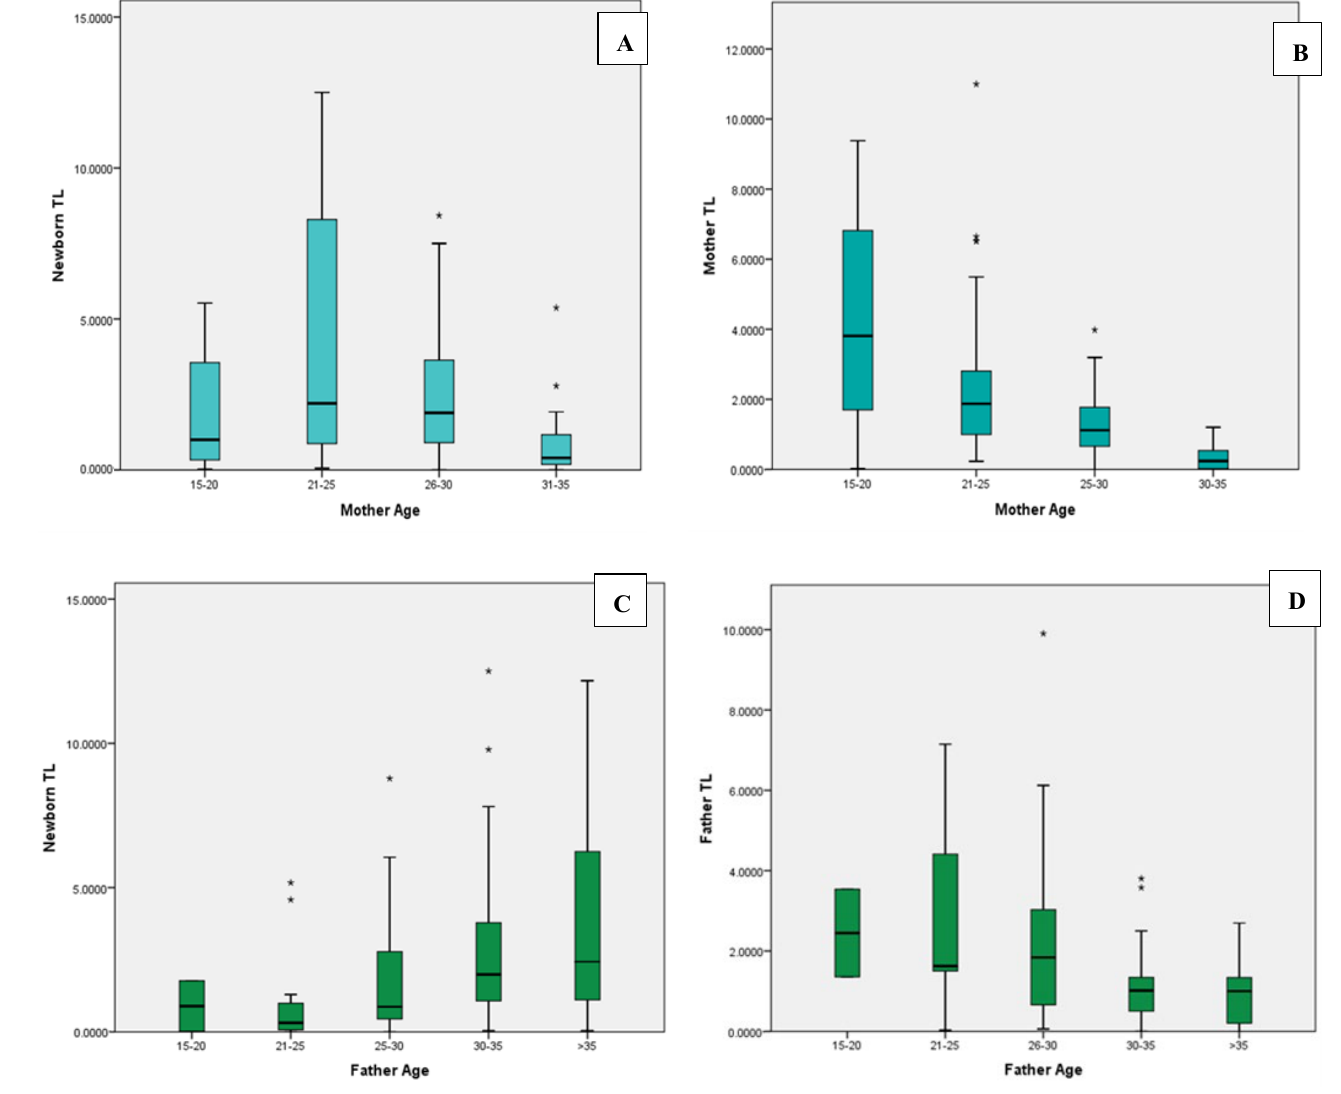
Figure 2. ( A , B ) Comparison of mother age with newborn telomere length. The longest newborn telomere length (TL) was seen in mothers aged 21–25, whereas TL in mothers decreases with an increase in their age. ( C , D ) Comparison of fathers’ age with newborn telomere length. An increase in fathers’ age showed an increase in newborns TL. The longest father TL was seen in ages 21–25. (*) symbol for p < 0.05; (**) for p < 0.01; (***) for p < 0.001. Table 2. Maternal antenatal clinical parameters and their effect on newborn telomere